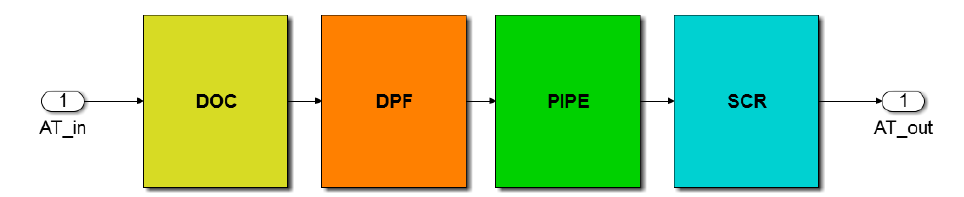
Figure 6. Example of after-treatment submodels for a Diesel Euro6 exhaust